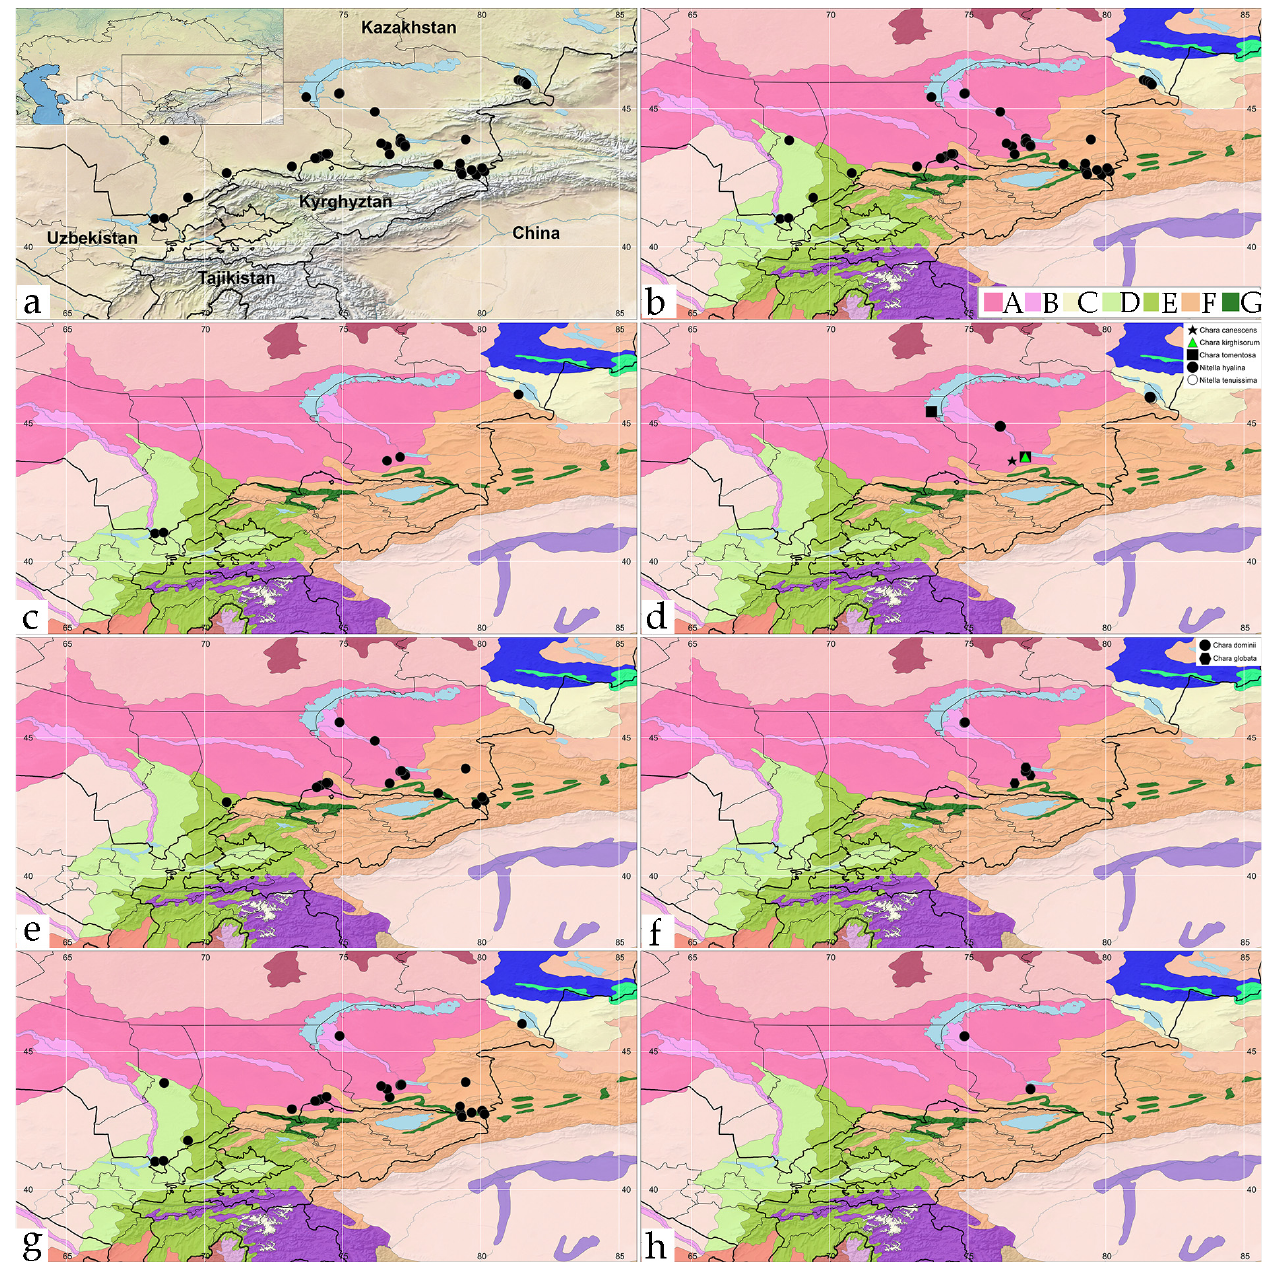
Figure 1. Species distribution in context of elevation ( a ) and ecoregions ( b – h ) in the regions studied: ( a , b )—all species, ( c )— Chara aspera , ( d )— C. canescens (1), C. kirghisorum (2), C. tomentosa (3), Nitella hyalina (4), ( e )— C. contraria , ( f )— C. dominii (1), C. globata (2), ( g )— C. vulgaris , ( h )— Nitellopsis obtusa . Ecoregions [56]: A—Central Asian northern desert, B—Central Asian riparian woodlands, C—Emin Valley steppe, D—Alai-Western Tian Shan steppe, E—Gissaro-Alai open woodlands, F—Tian Shan montane steppe and meadows, G—Tian Shan montane conifer forests.